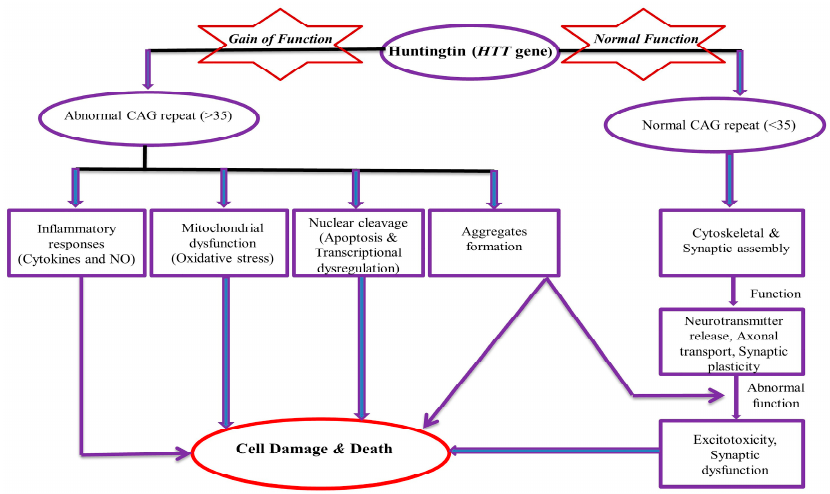
Figure 1. Mechanism of Toxicity of Huntingtin ( HTT ) gene. NO (Nitric Oxide), CAG (cytosine-adenine-guanine).